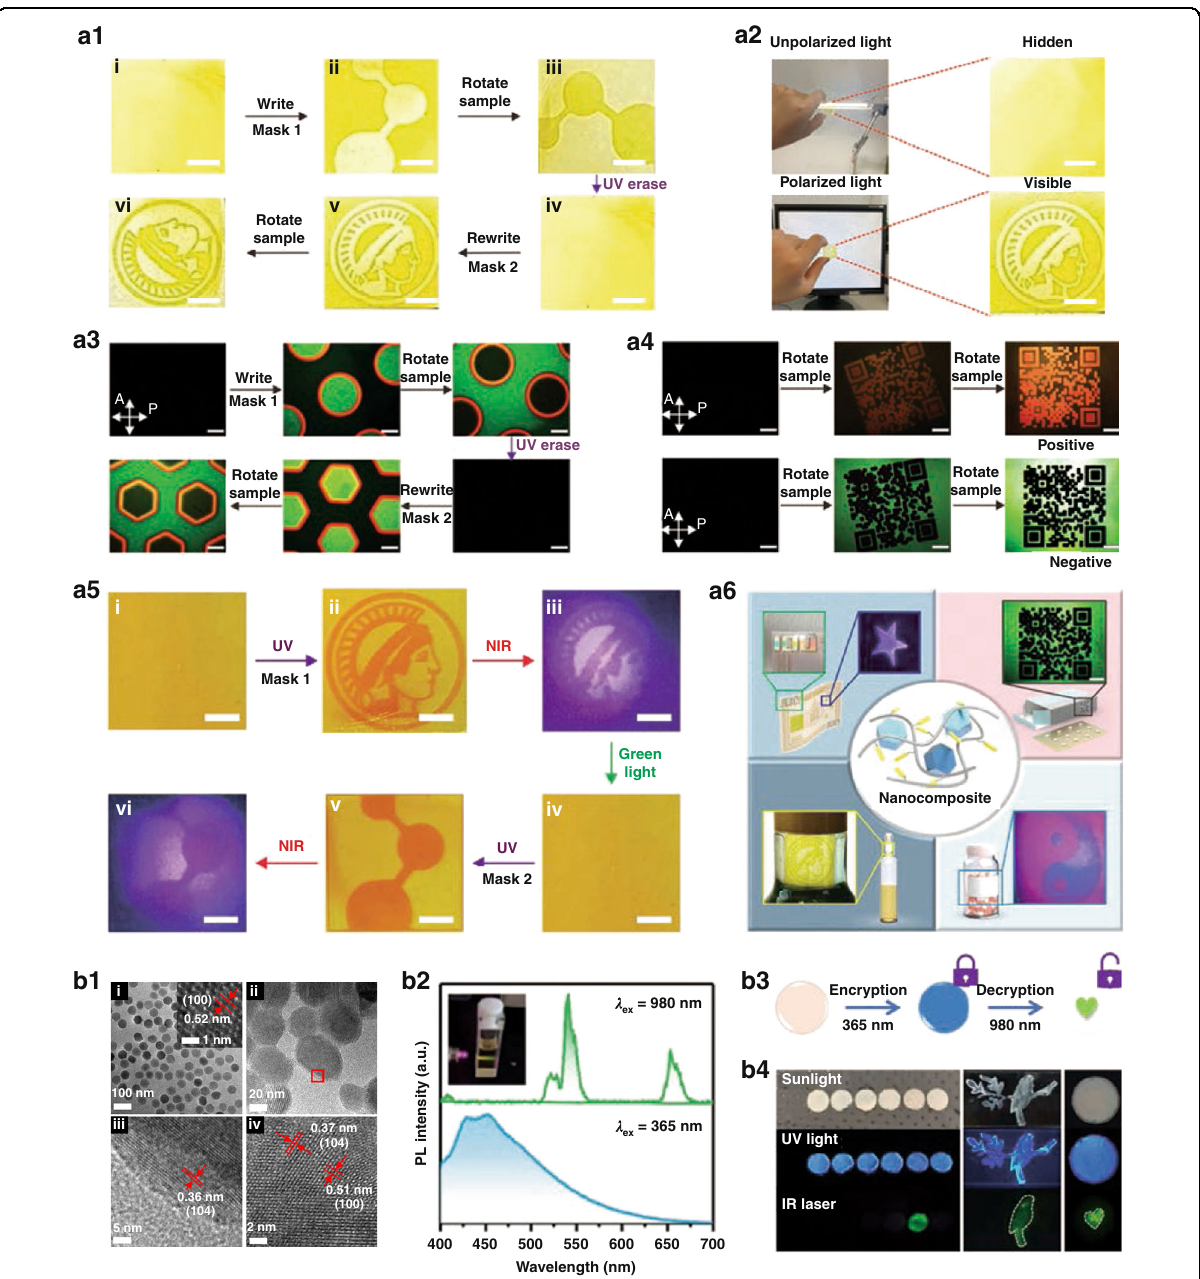
Fig. 9 Anti-counterfeiting applications. a1 Photographs of erasable and rewritable macropolarization-related patterns of nanocomposite fi lm. Scale bars stand for 0.5 mm. a2 Photographs of macroscopic polarization-dependent patterns under unpolarized and polarized light. Scale bars stand for 0.5 mm. a3 Polarization microscope photographs of microscopic polarization correlation patterns. Scale bars: 200 μ m. a4 QR code pattern on different backgrounds under polarized light microscope. Scale bars: 200 μ m. a5 Photographs of photochromic UCL patterns of PAzo/UCNPs